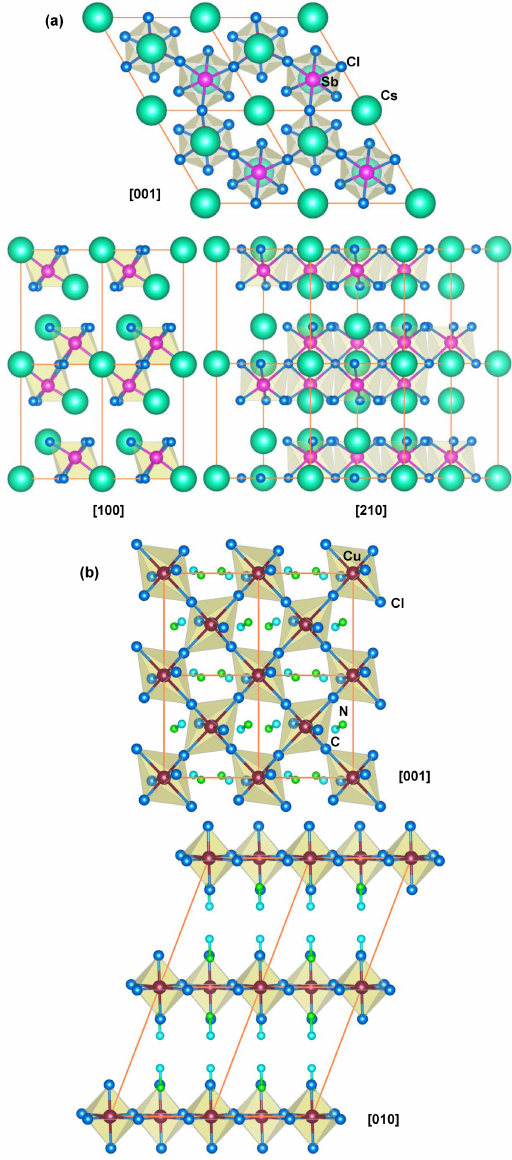
Figure 34: Calculated X-ray diffraction patterns of α -Cs 3 Sb 2 Cl 9 , β -Cs 3 Sb 2 Cl 9 , and CsTiCl 3